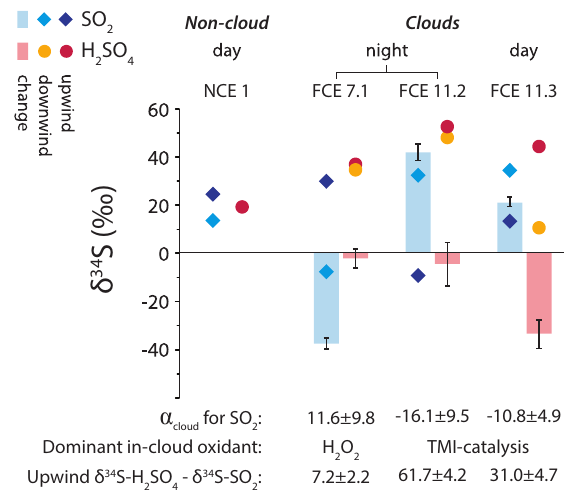
Fig. 4. Isotopic composition of SO 2 (gas) and H 2 SO 4 (gas + ul- trafine particulate) upwind and downwind of orographic clouds during the HCCT-2010 campaign. Points show the upwind and downwind values of δ 34 S while columns show the change (change = δ 34 S − δ 34 S downwind upwind ) and the 1 σ error of the